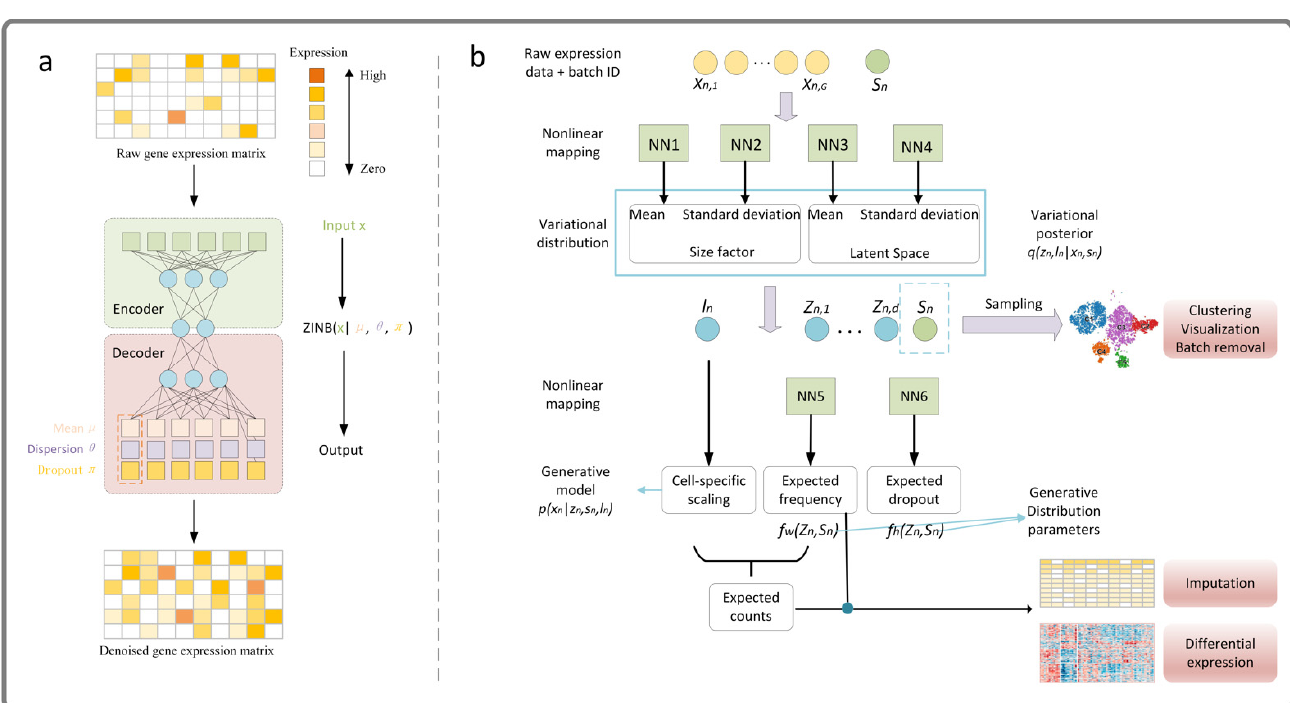
Figure 11. The framework of DCA ( a ) and scVI ( b ) method [32,84].